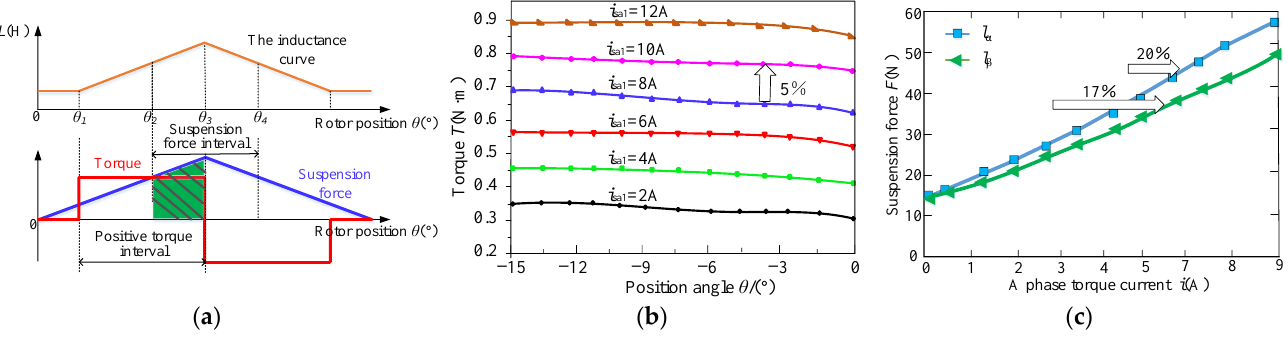
Figure 2. ( a ) Ideal inductance curve, torque and suspension force curves; ( b ) Torque curves; and ( c ) Variation curves of suspension force.